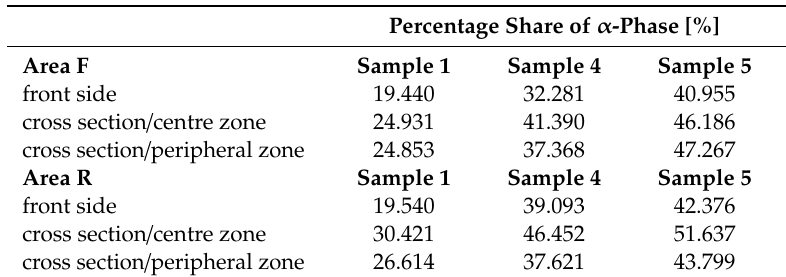
Table 7. Percentage share of α -phase in the grinding.